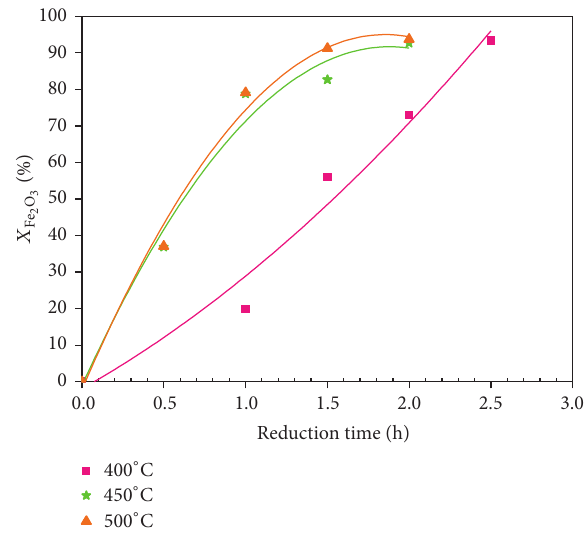
Figure 6: Effect of reaction time on the conversion of Fe 2 O 3 at different